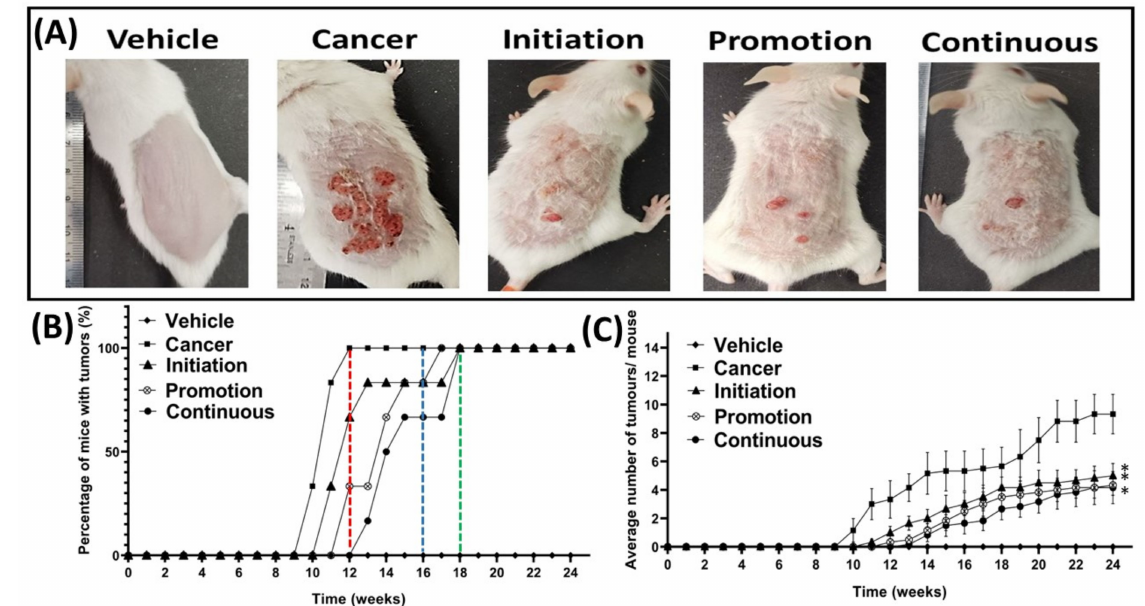
Figure 3. Effect of oral pterostilbene during the initiation, promotion, or continuous in a mouse model of skin SCC induced chemically by DMBA/TPA. ( A ) The macroscopic observation of the dorsal skin of representative mice from the Vehicle, cancer, Initiation, Promotion, and Continuous groups at week 24. ( B ) the percentage of mice with tumours with a red line marked at week 12 where the Cancer control group achieved a 100% incidence rate, a blue line marked the Promotion group achieved a 100% incidence rate at week 17, and a green line marked the Initiation, and Continuous groups achieved 100% at week 18. ( C ) The average number of tumours per mouse (mean ± SEM). * there is a statistically significance difference to the Cancer control group ( p < 0.05) at week